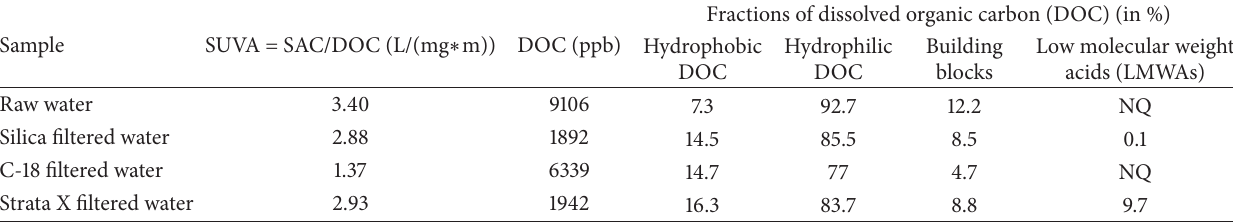
Table 3: Raw and SPE filtered water